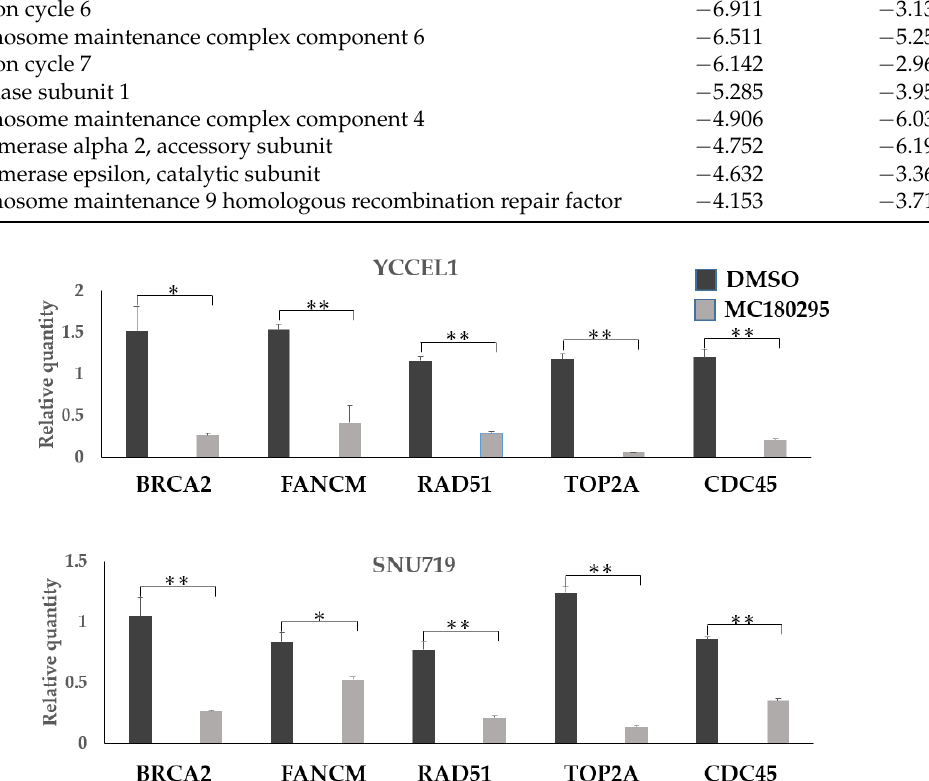
Figure 3. Gene expression levels after MC180295 treatment. The expression levels of BRCA2 , FANCM , and RAD51 decreased in both YCCEL1 and SNU719 cells treated with MC180295, as well as those of TOP2A and CDC45 . Data were obtained from three independent experiments. Bars denote SE ( n = 3), * p < 0.05. ** p < 0.01.